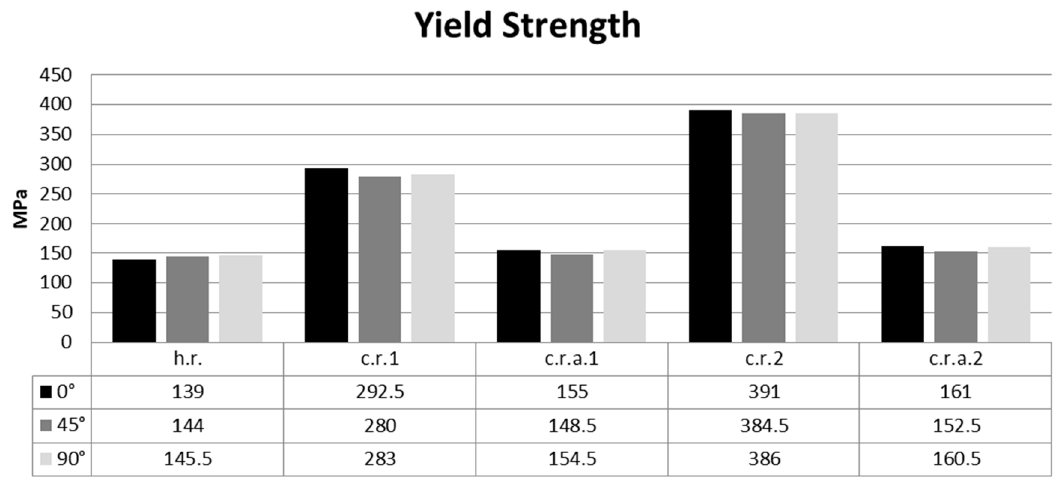
Figure 6. Yield strength data for all products and conditions.